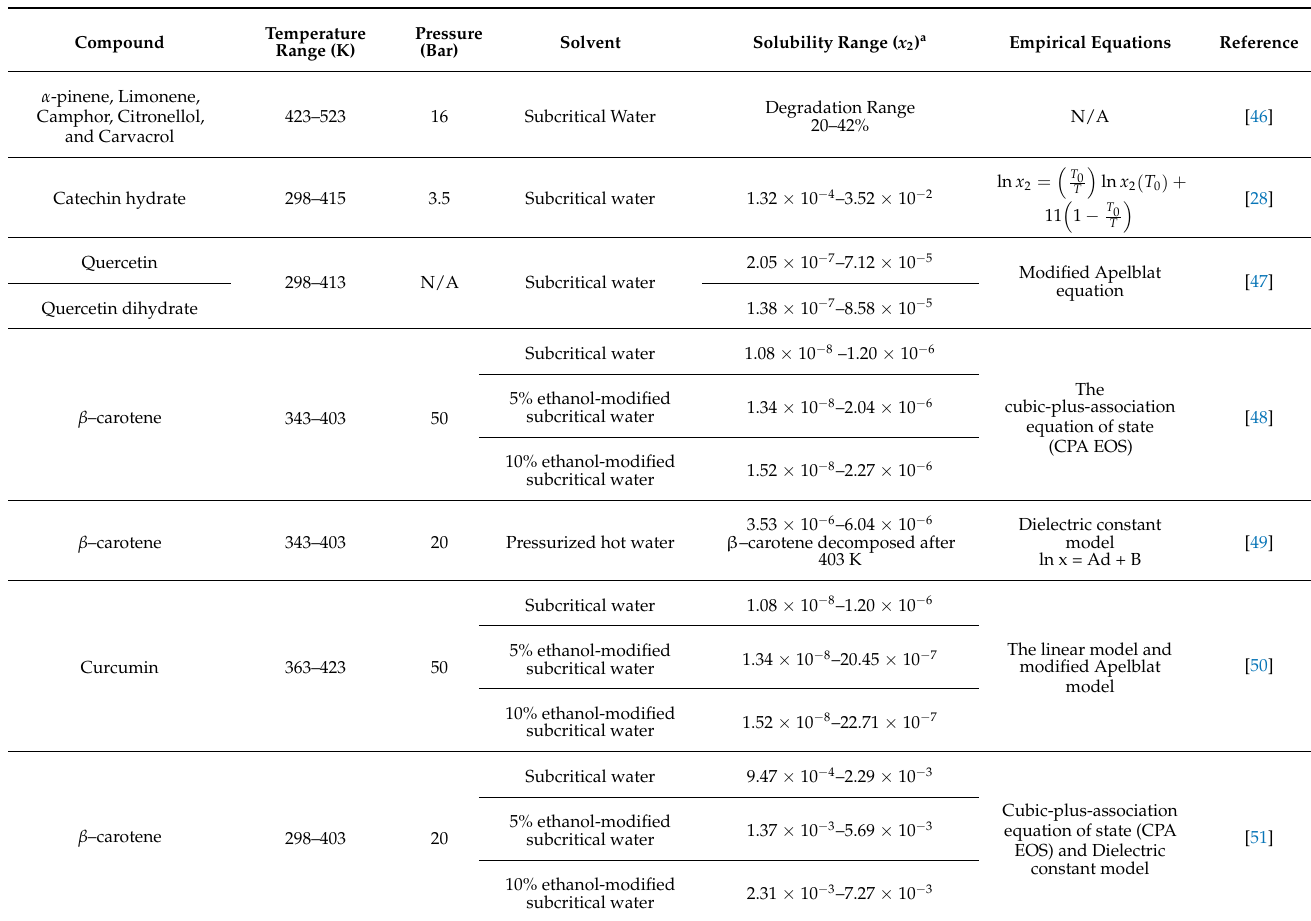
Table 5. Carotenoid and flavonoid solubility and degradation in subcritical